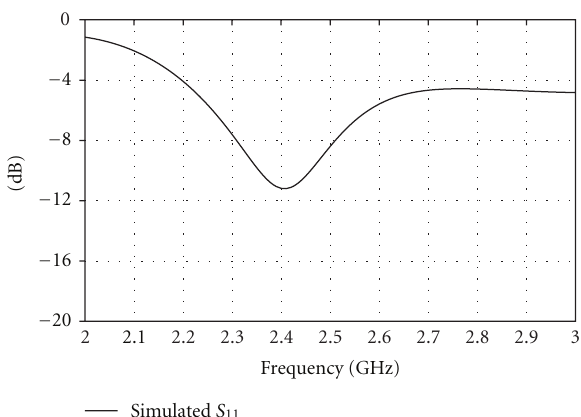
Figure 6: Simulated return loss of the dipole antenna with reflector and director.